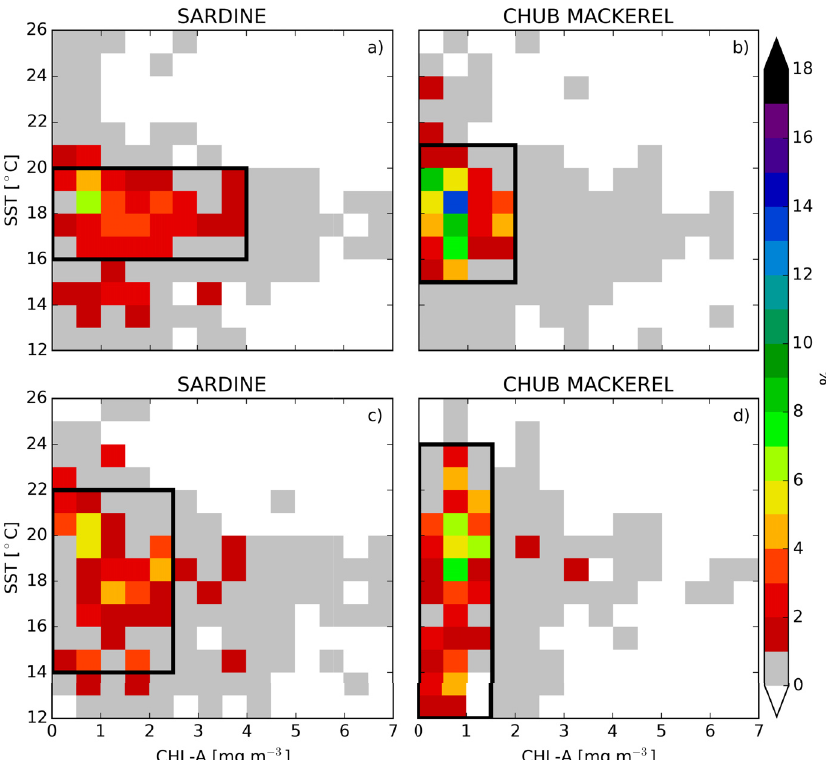
Fig. 4. Bivariate distributions of SST and Chl-a for sardine ((a) WAOI; (c) SAOI) and chub mackerel ((b) WAOI; (d) SAOI) catches for depths between 20 and 60m, for 2014 – 2015. The black rectangles identify SST and Chl-a ranges used in Figure